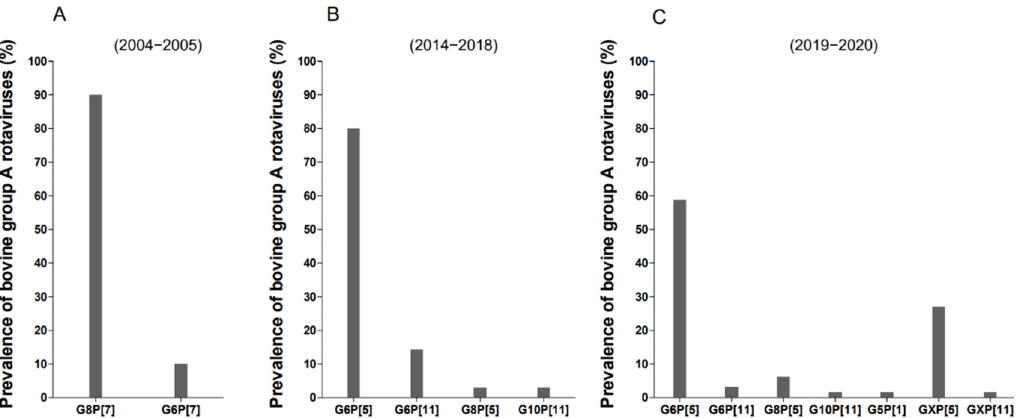
Figure 1. Distribution of the combined G and P BoRVA strains circulating in cows in South Korea.